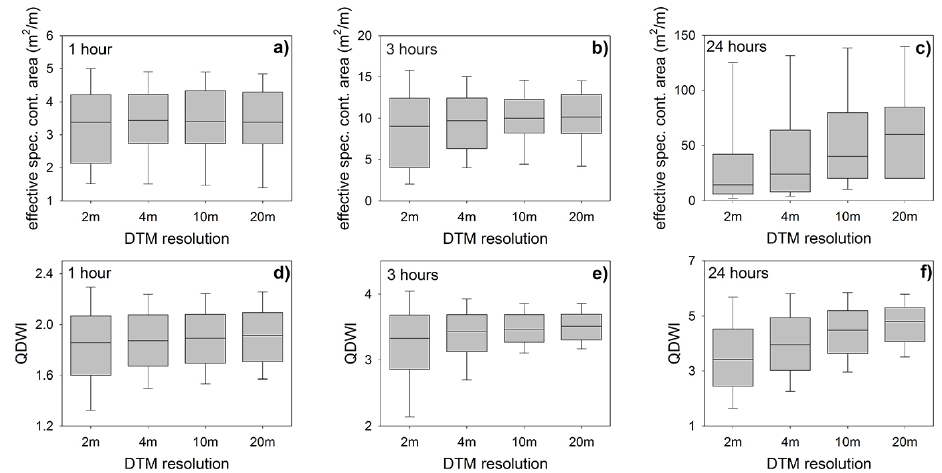
Figure 5. Box plots of topographic attributes for the four different DTM resolutions: (a) to (c) effective specific contributing area for drainage time ranging from 1 to 24h, (d) to (f) QDWI for drainage time ranging from 1 to 24h. The boxes show the 25th and 75th percentile, the whiskers show the 10th and 90th percentile, the horizontal line within the box indicates the median.